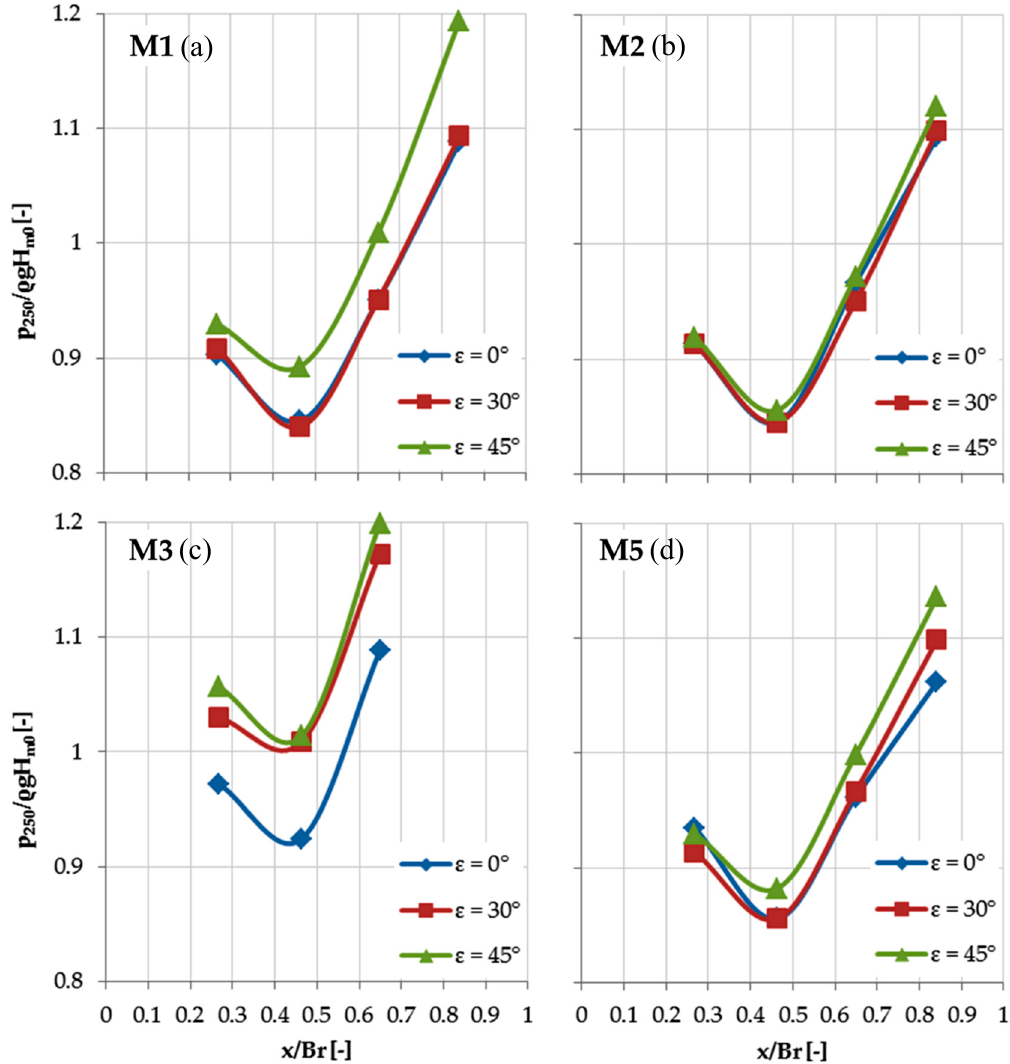
Figure 12. The non-dimensional pressures inside the reservoir for the configurations ( a ) M1, ( b ) M2, ( c ) M3 and ( d ) M5. The statistical values of p 250 divided by the wave height (H m0 ), the water density ( ρ ) and the gravitational acceleration (g) are reported on the ordinate; while the relative abscissa (x) of pressure transducers from the seaward border of the reservoir has been non-dimensionalised with respect to the reservoir width (Br), on the abscissa.